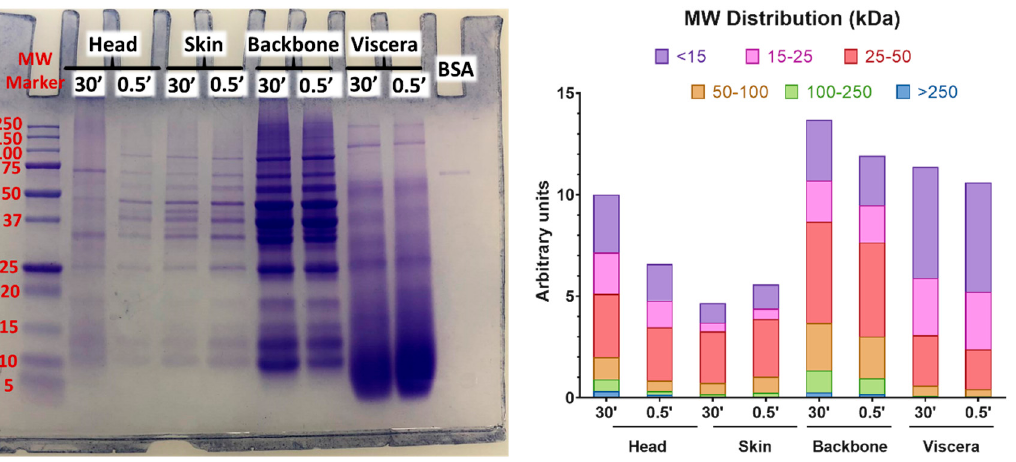
Figure 7. SDS-PAGE analysis of extracts obtained by UAE from sea bass byproducts (head, skin, bone, and viscera) (MW, molecular weight).